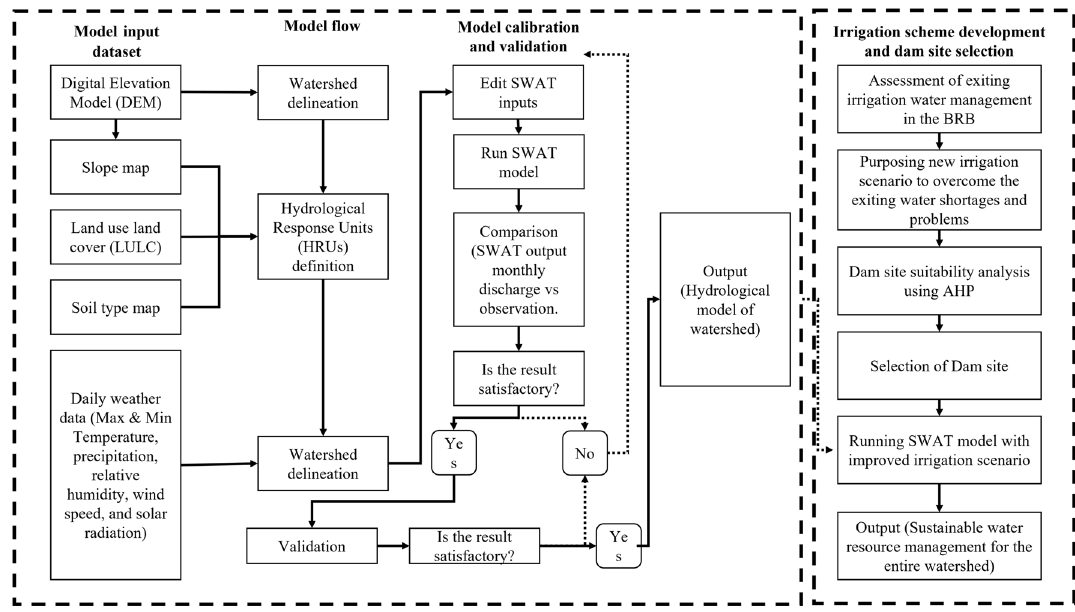
Fig. 2 Methodological flow chart for hydrological modelling with SWAT and sustainable water resource management and dam site suitability analysis using